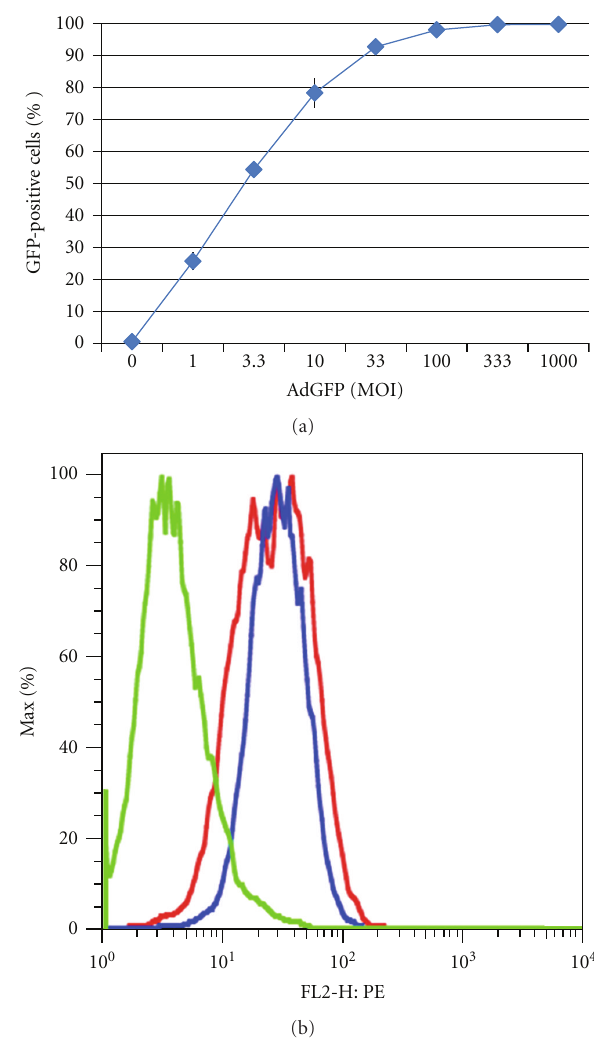
Figure 6: Adenoviral infectivity and surface expression in 22Rv1 cells. (a) 22Rv1 cells were transduced with increasing amounts of AdGFP. The presence of GFP-positive cells was quantified by flow cytometry at 48hrs after transduction. Data shown are the mean ± SD of an assay performed in duplicate. (b) Surface CAR expression was determined by flow cytometry (green = isotype, blue = anti- CAR, untreated cells, and red = anti-CAR in cells treated with 10 µ M MS-275).